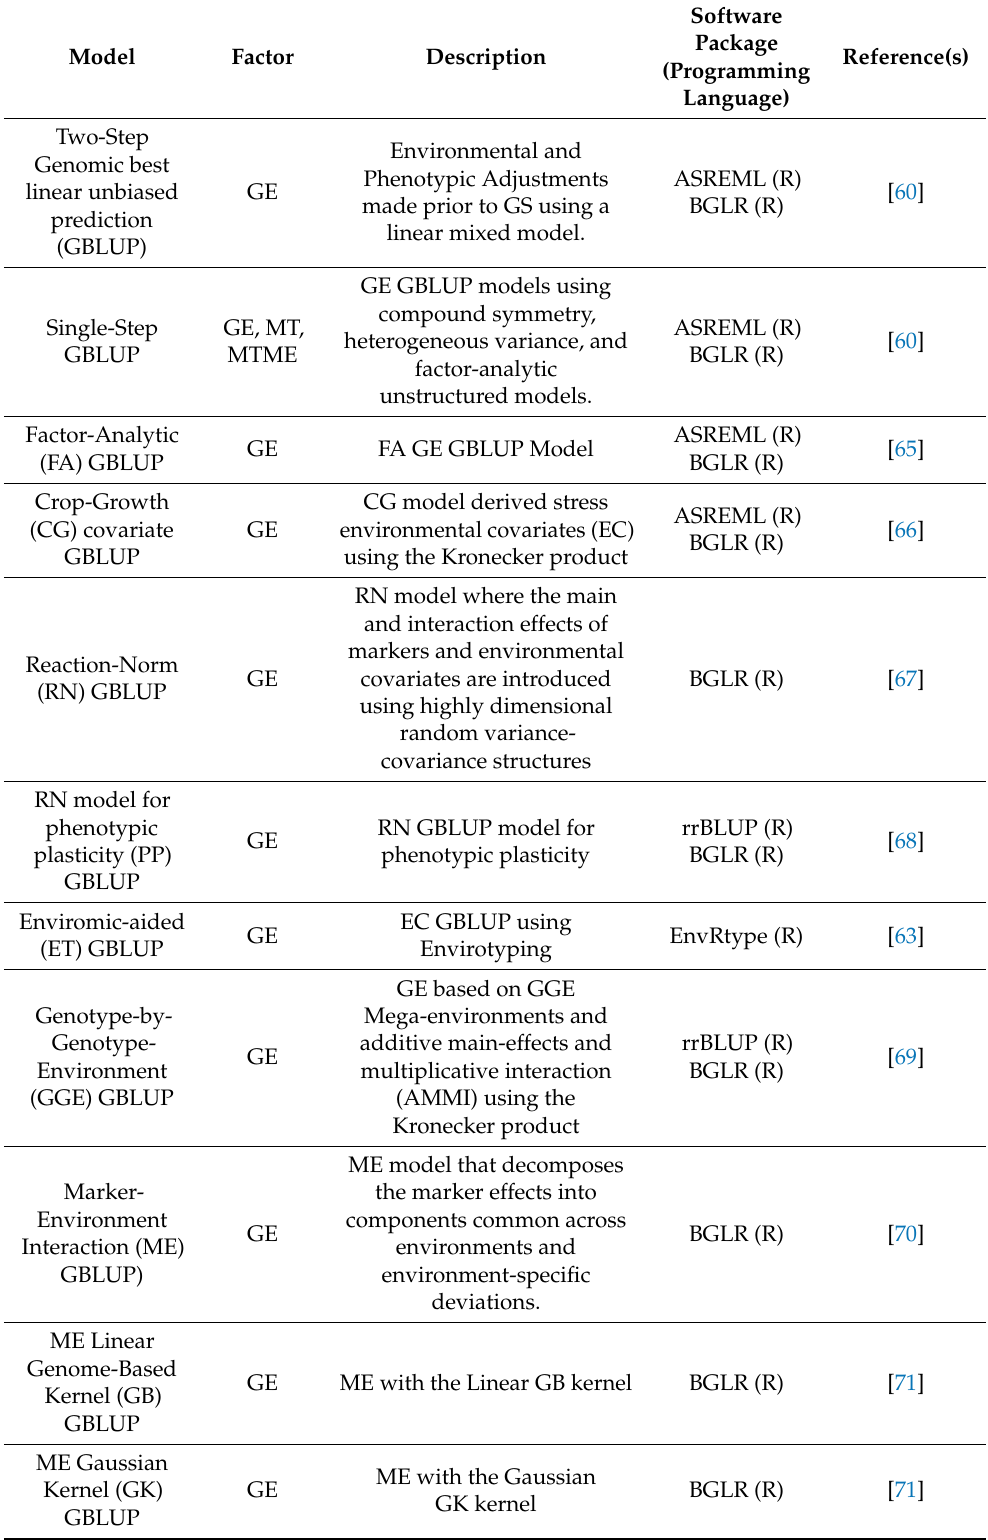
Table 1. Genomic selection (GS) models leveraging phenotypic data for multi-trait (MT), genotype- by-environment interaction (GE), and multi-trait, multi-environment (MTME) models that have shown an increase in prediction accuracy over single-environment, single-trait, GS